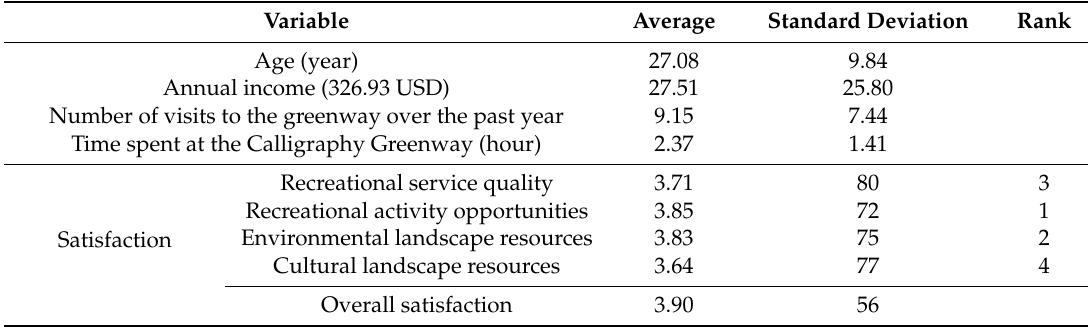
Table 4. Analysis of the descriptive statistics for basic visitor